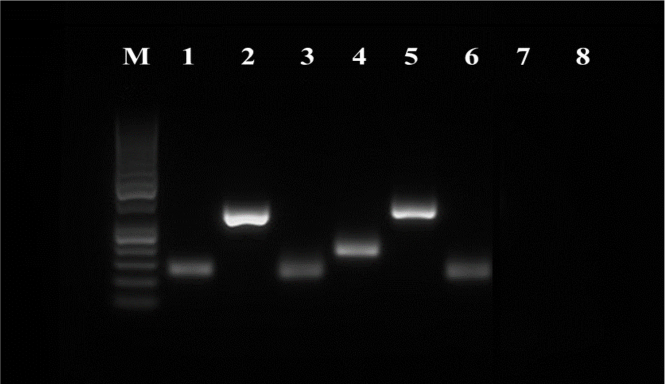
Figure 5. RT-PCR analysis of the expression of rAT-MSCs surface markers. Lane M—50 bp DNA ladder (Thermo Fisher Scientific, USA); lane 1—B2M (control); lane 2—CD29; lane 3—CD44; lane